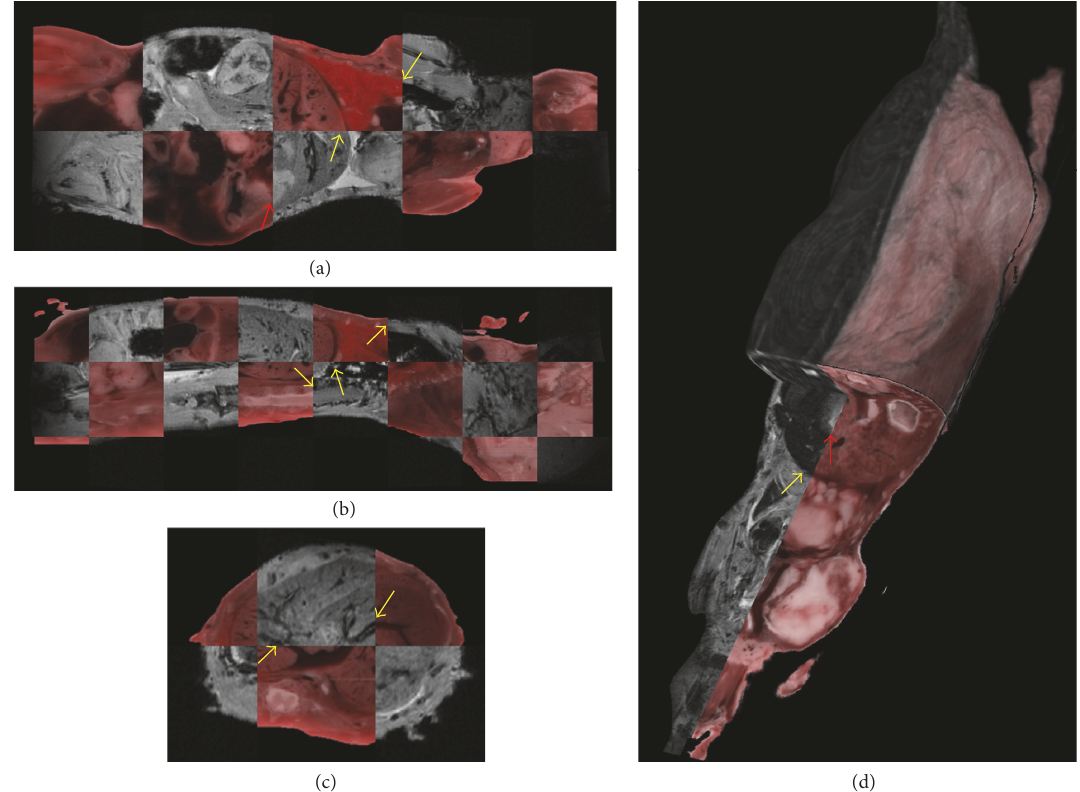
Figure 5: Visual evaluation of registration quality for whole mouse. Figure shows multiplanar checker board view of registration results. In (a) yellow arrows point at edges of lungs and liver in 𝑋𝑌 view; red arrows point at parts of intestine showing misregistration. In (b) arrows point at edges of lungs, liver, and spinal cord in 𝑋𝑍 view, and in (c) a blood vessel in liver is shown in 𝑌𝑍 view. (d) 3D visualization to assess